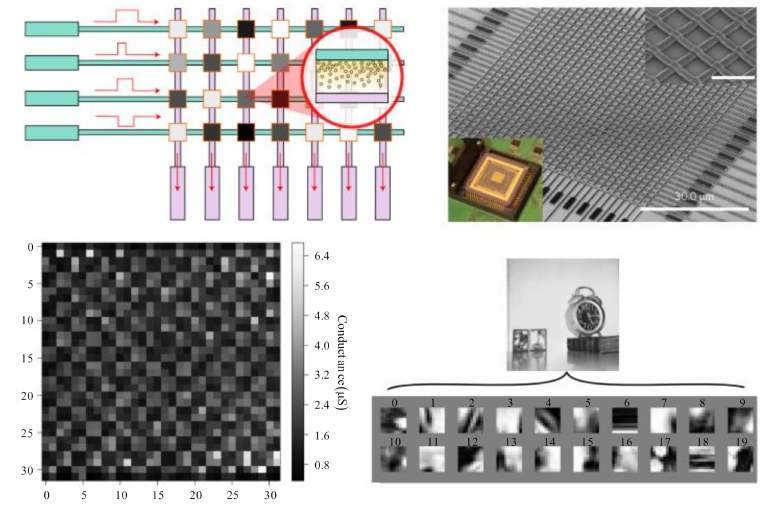
Figure 7. Memristor crossbar array-based computing hardware system.